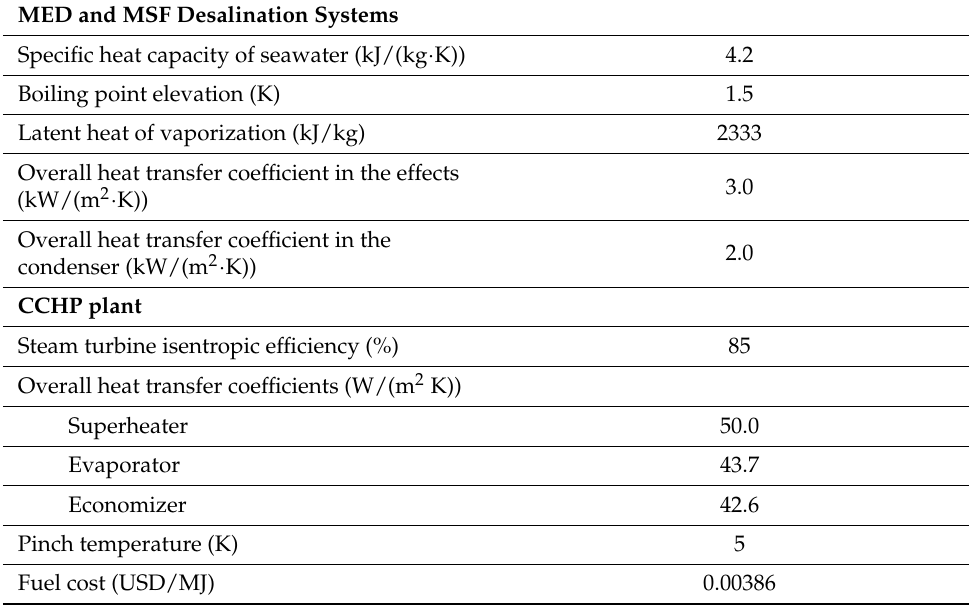
Table 2. Parameter values used in the mass and energy